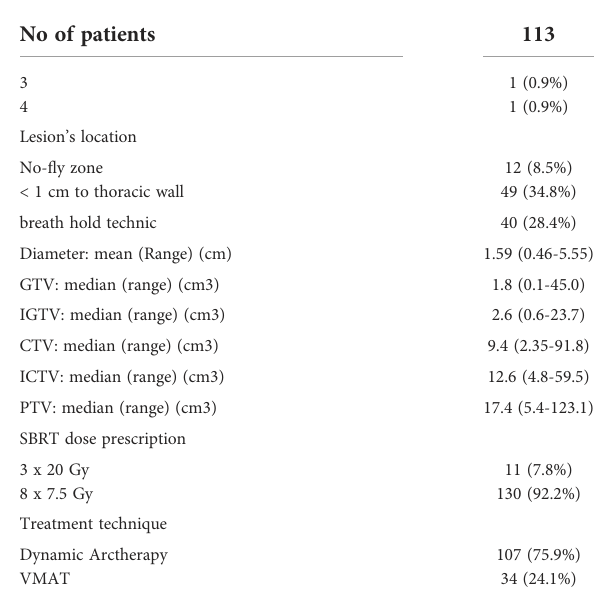
TABLE 1 Patient, tumor, and treatment